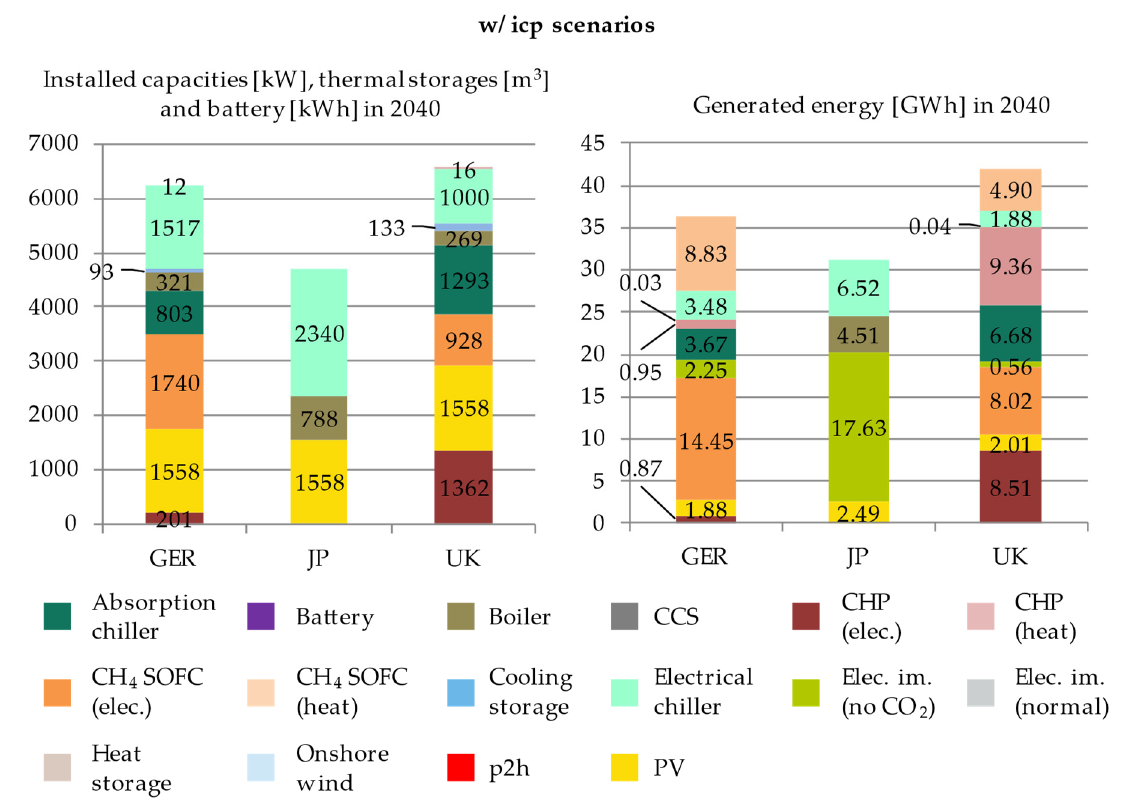
Figure 10. Country comparison for “w/ICP” scenarios.